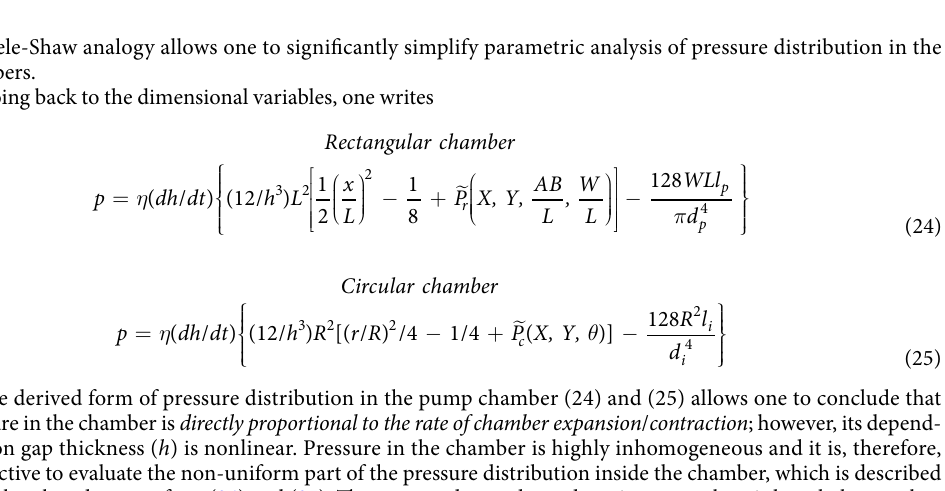
Figure 4. Example of FEM mesh used for pressure calculations. Each triangular finite element provides three pressure values associated with three nodes. The nodes are concentrated in the vicinity of points A and B where boundary conditions change. In this example, opening AB was 2 θ = 2 π /5, and 25 refinements were used. Dense nodes indicate high pressure gradients, whereas sparse nodes indicate lower